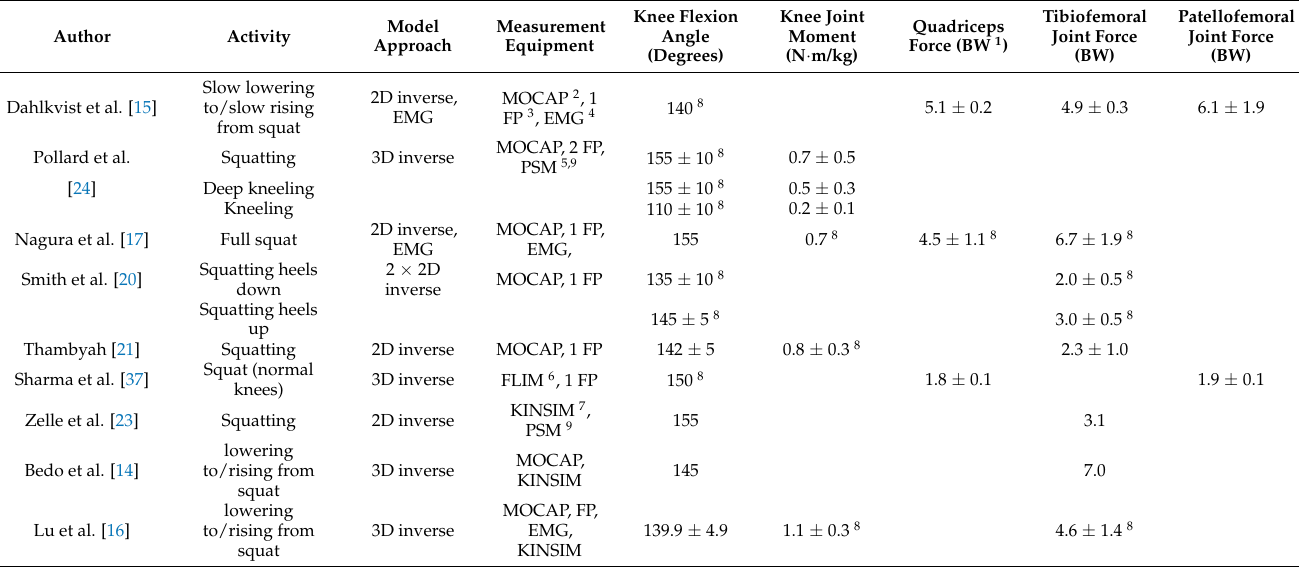
Table 3. Comparison of cited studies that investigated knee joint forces during kneeling and squatting postures—means and standard